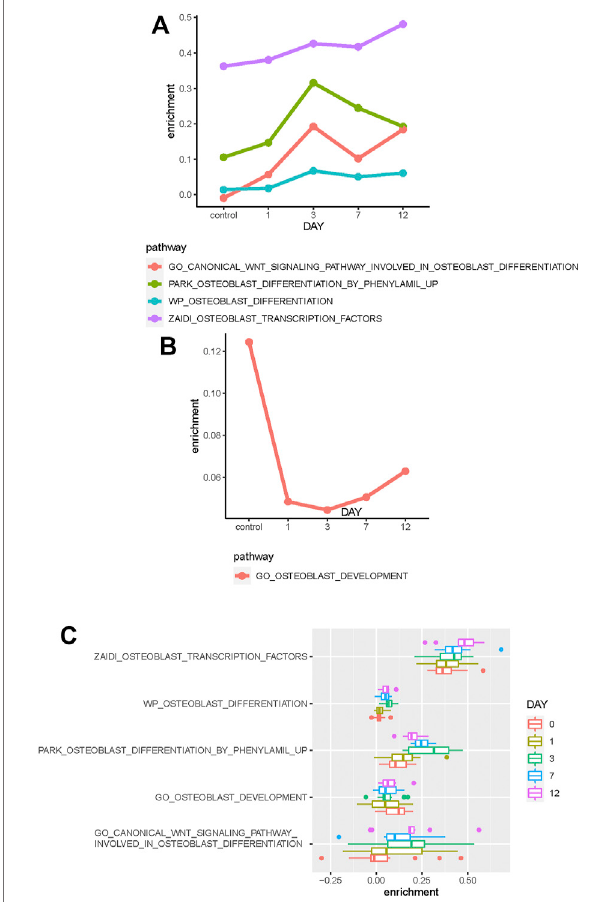
FIGURE 3 | Identi fi cation of differentially enriched pathways. (A) Four osteoblast-related pathways tend to be upregulated in the osteogenic process. (B) One osteoblast-related pathway tends to be downregulated in the osteogenic process. (C) Boxplot shows these differentially enriched pathways of samples. Samples are divided into different groups based on osteogenic